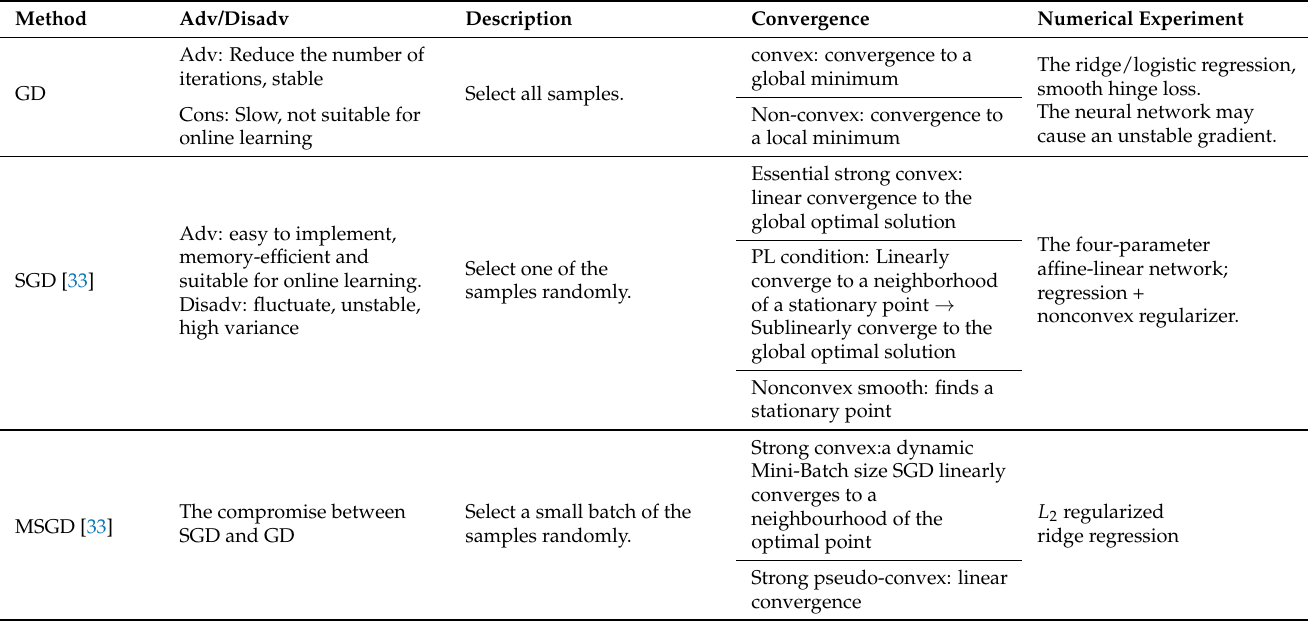
Table 2. The comparison of SGD, GD, and mini-batch